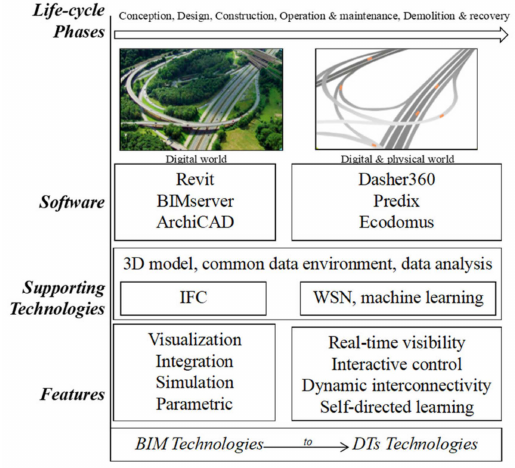
Figure 1. Research